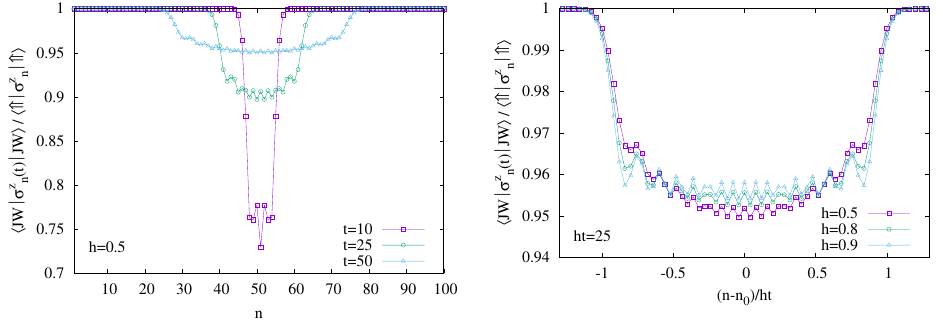
Figure 3: Normalized transverse magnetization profiles for JW excitation in a chain of length N = 100. Left: for h = 0.5 and various t . Right: for various h with ht = 25 kept fixed, on a rescaled horizontal